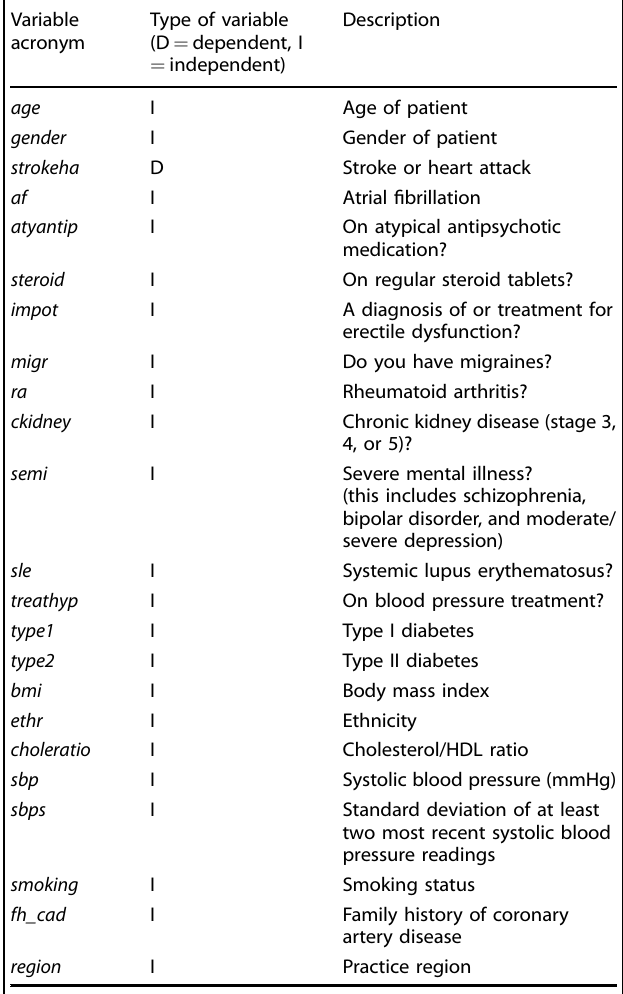
Table 7. Description of the selected features used from CPRD for analysis based on predicting cardiovascular disease.